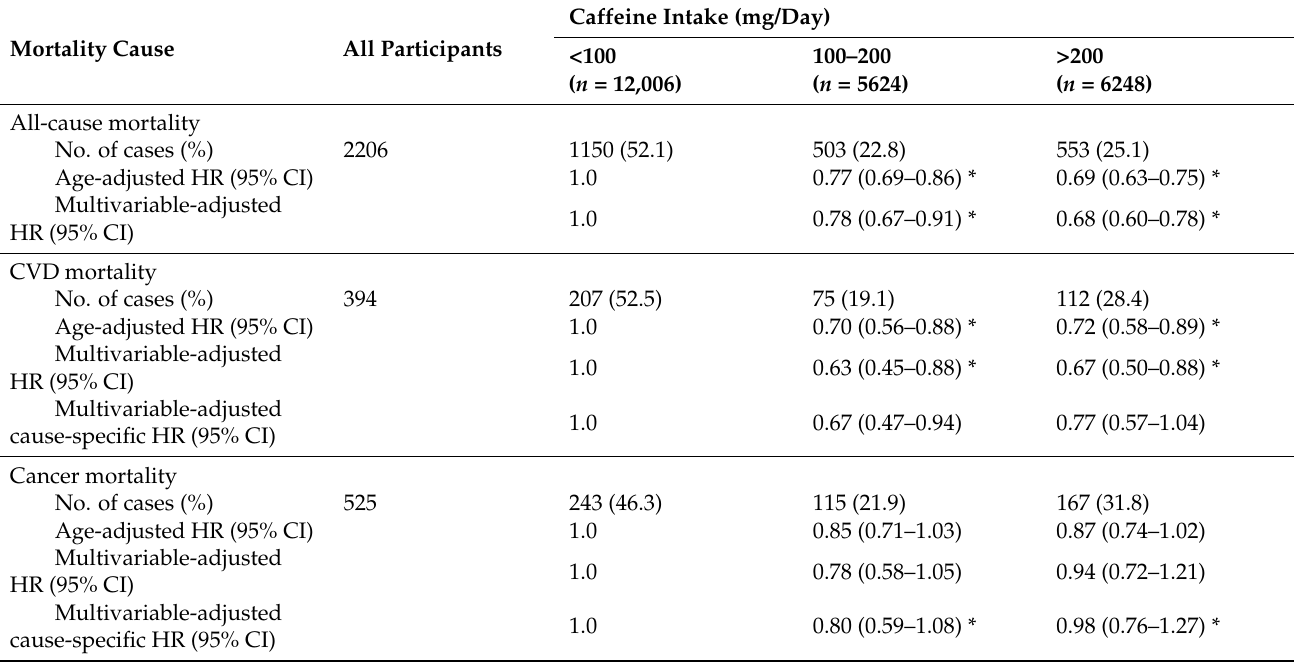
Table 2. Hazard Ratios for All-Cause and Cause-Specific Mortality by Daily Caffeine Intake in the National Health and Nutrition Examination Survey